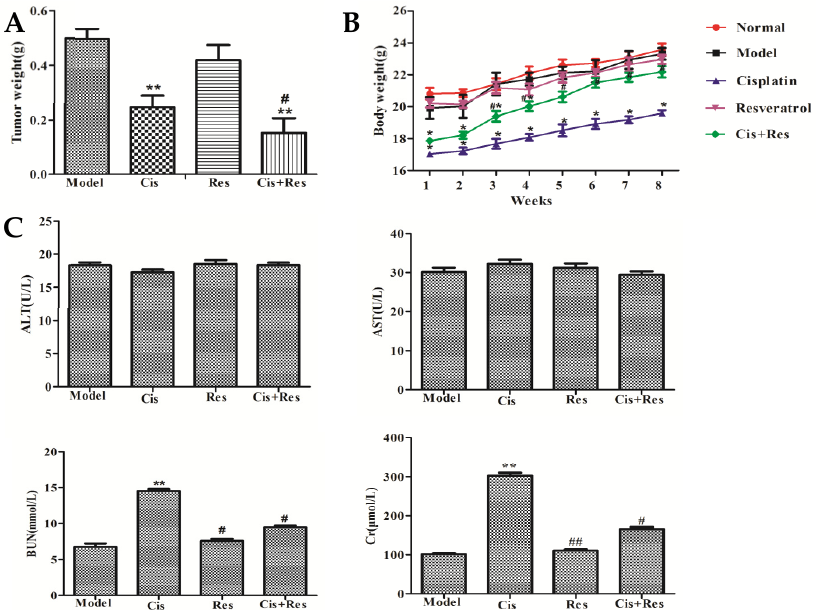
Figure 5. Anti-tumor effect of resveratrol and cisplatin without side effects in MDA231 xenografts. ( A ) Effects on tumor weight; ( B ) effects on body weight; ( C ) effects on serum ALT, AST, BUN, and Cr. ** p < 0.01, * p < 0.05 vs. model group; ## p < 0.01, # p < 0.05, vs. cisplatin-treated group.